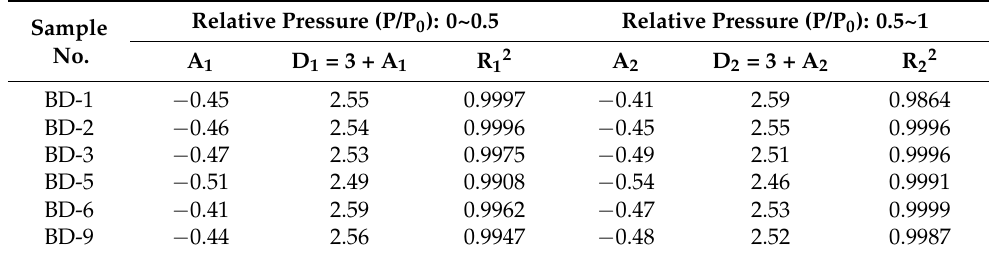
Table 6. Fractal dimension of typical samples in the study area.